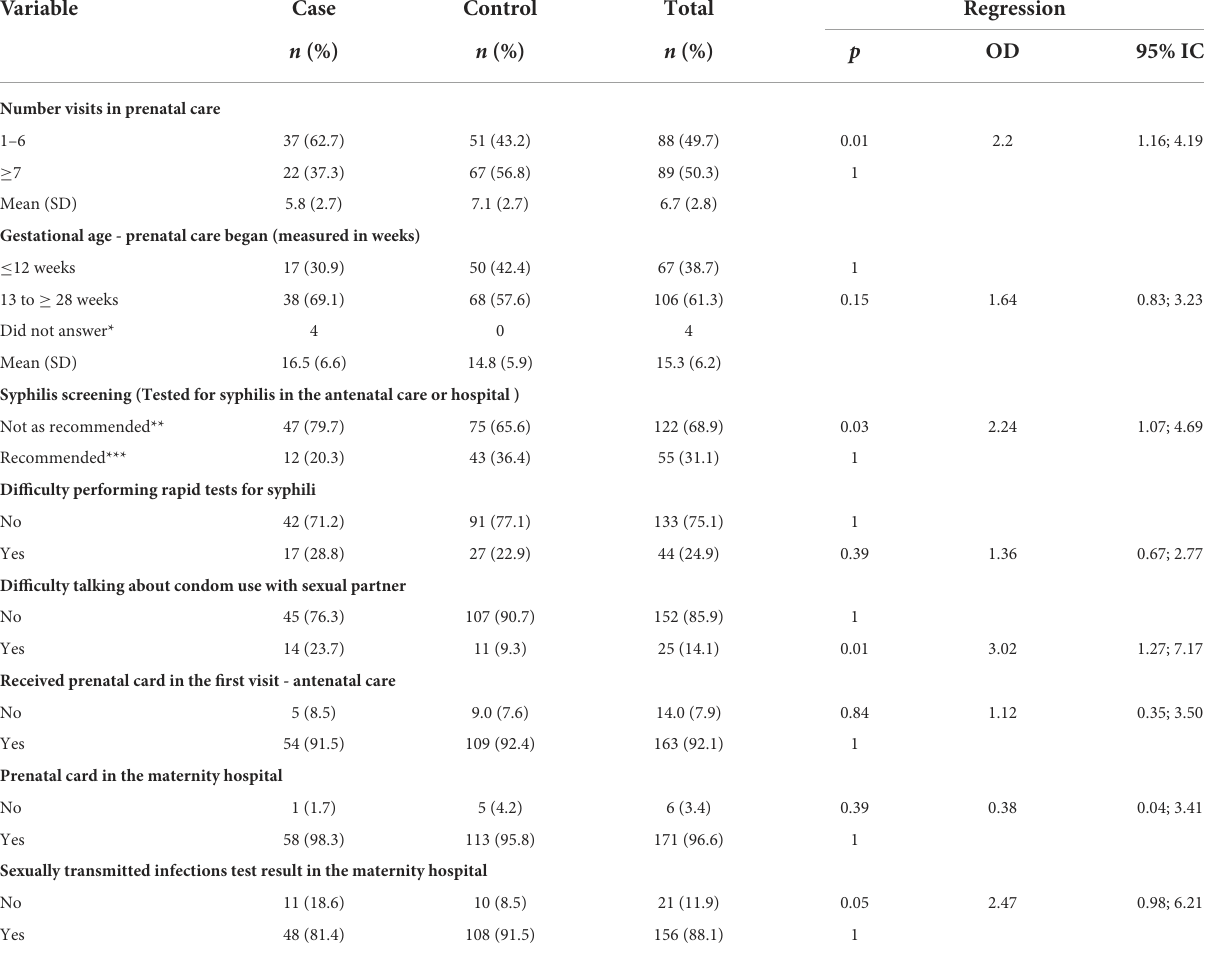
TABLE 2 Programmatic factors associated with gestational syphilis, in the Brazilian Amazon, 2020–2021.